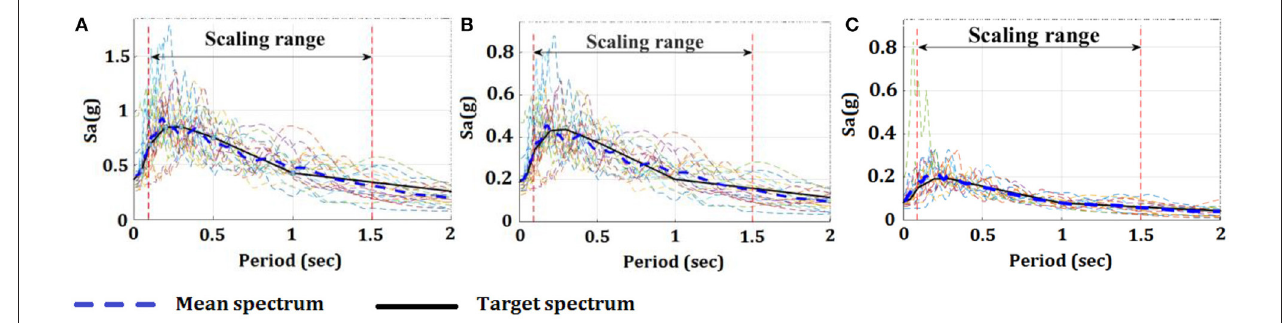
FIGURE 5 | Response spectra of scaled ground motions at (A) the 2/50 hazard level, (B) the 10/50 hazard level, and (C) the 40/50 hazard level (Target spectrum from Natural Resources Canada (NRC), 2016).